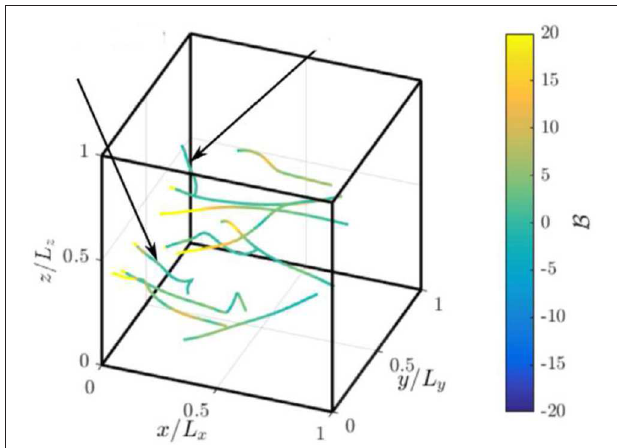
FIGURE 8 | Evolution of B along Lagrangian tracks of chosen fluid parcels and the tracks are drawn for a duration from 1 to 1.5 τ f . This results is shown for the case NP3 in Table 2 , adapted from Doan (2018) under a Creative Commons